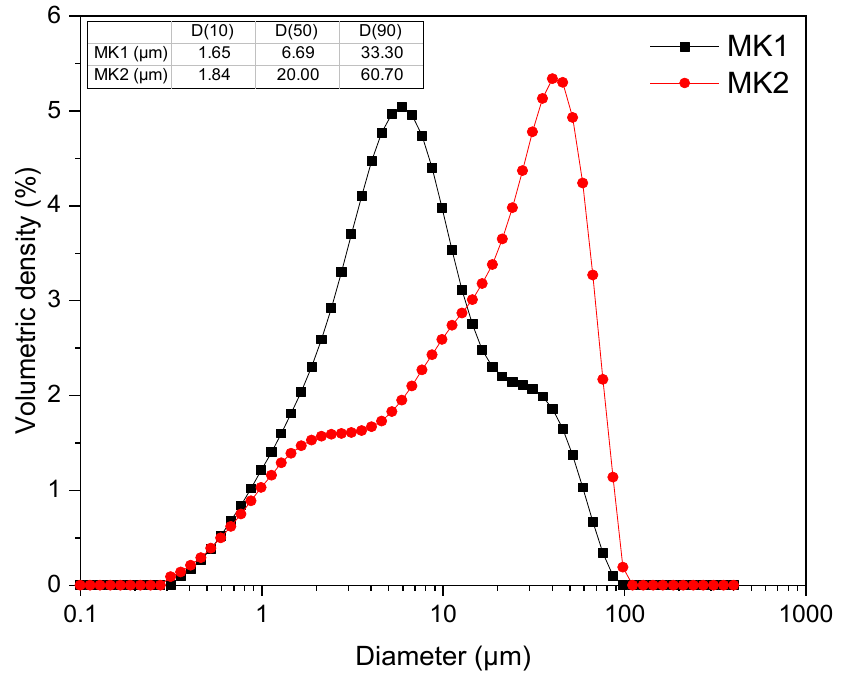
Figure 2. SEM image on: ( a ) MK1; ( b ) MK2 [×15,000].